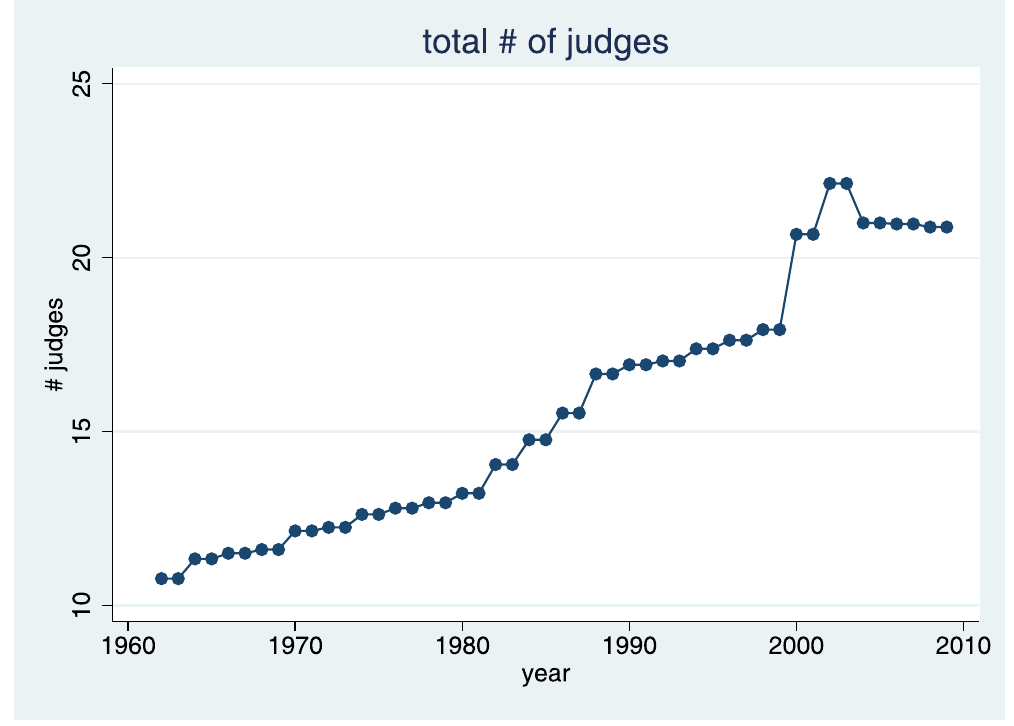
Fig 8. Number of Judges in Germany (in